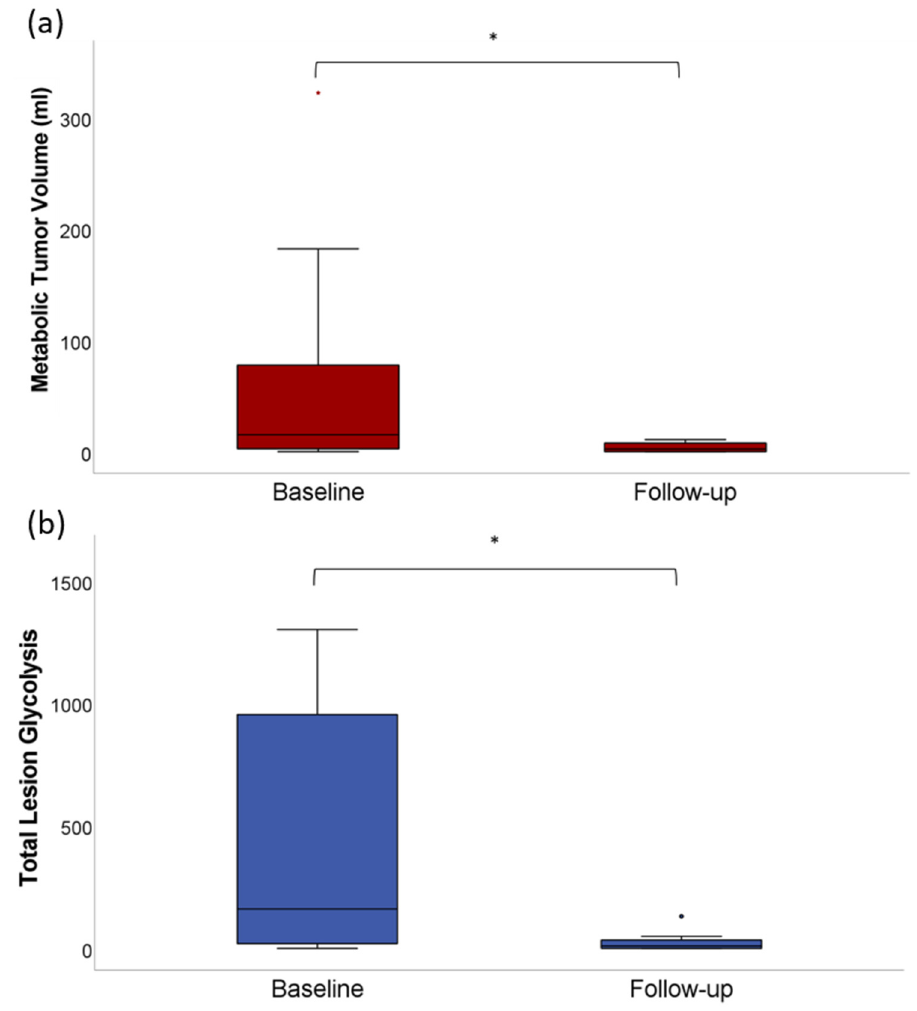
Figure 2. ( a ) Whole-body MTV at baseline 18 F-FDG-PET/CT before CAR T cell therapy (62 ± 86 mL) and at first follow-up 18 F-FDG-PET/CT (4 ± 5 mL) after CAR T cell therapy in the entire patient cohort ( p < 0.01). ( b ) Whole-body TLG at baseline 18 F-FDG-PET/CT before CAR-T cell therapy (925 ± 1722) and at first follow-up 18 F-FDG-PET/CT (33 ± 59) after CAR-T cell therapy in the entire patient cohort ( p < 0.01). The asterisk (*) indicates clinical significance ( p < 0.05).